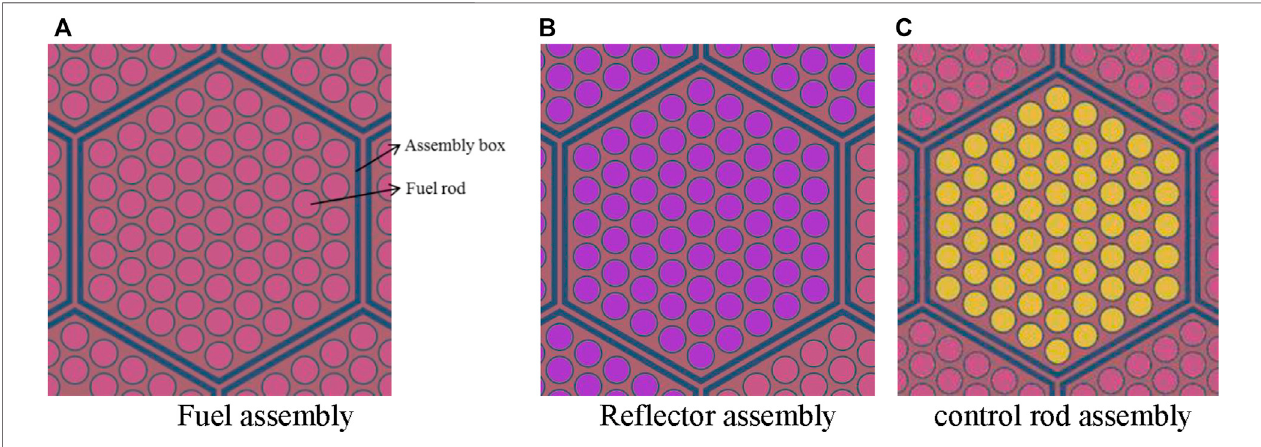
FIGURE 2 | Hexagonal assembly geometry of the